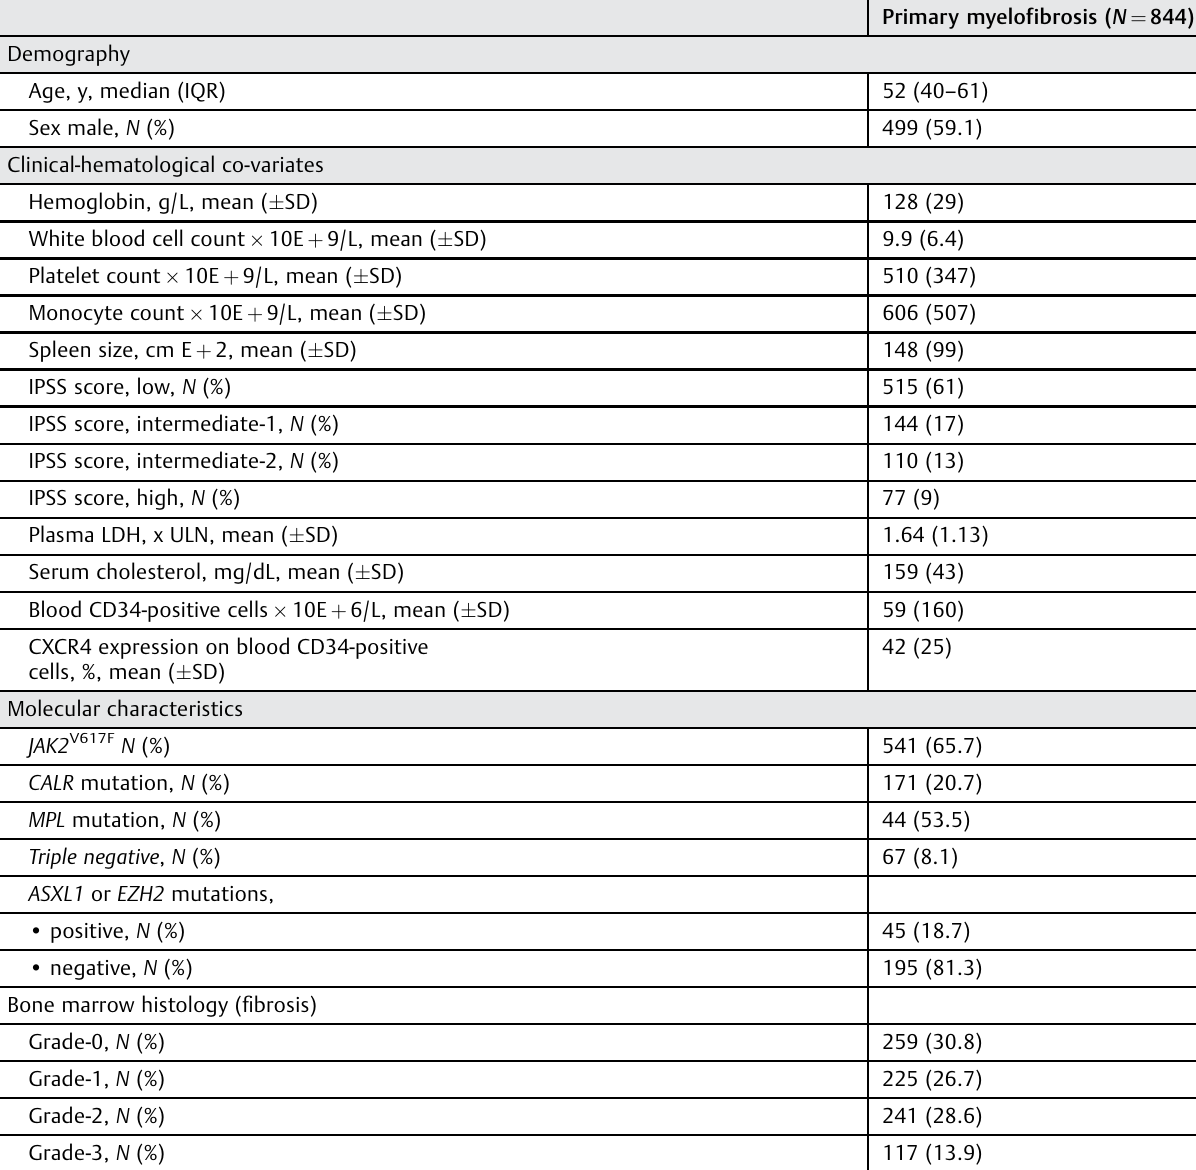
Table 1 Baseline characteristics of subjects with primary myelo fi brosis at diagnosis analyzed for rs3025020 VEGFA polymorphism